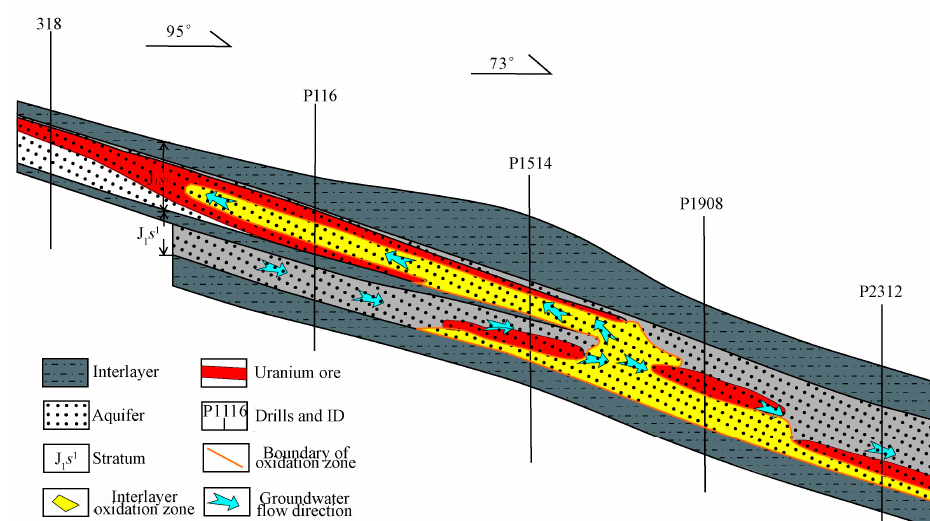
Figure 3. Aquifer and interlayer oxidation in the metallogenic belt.